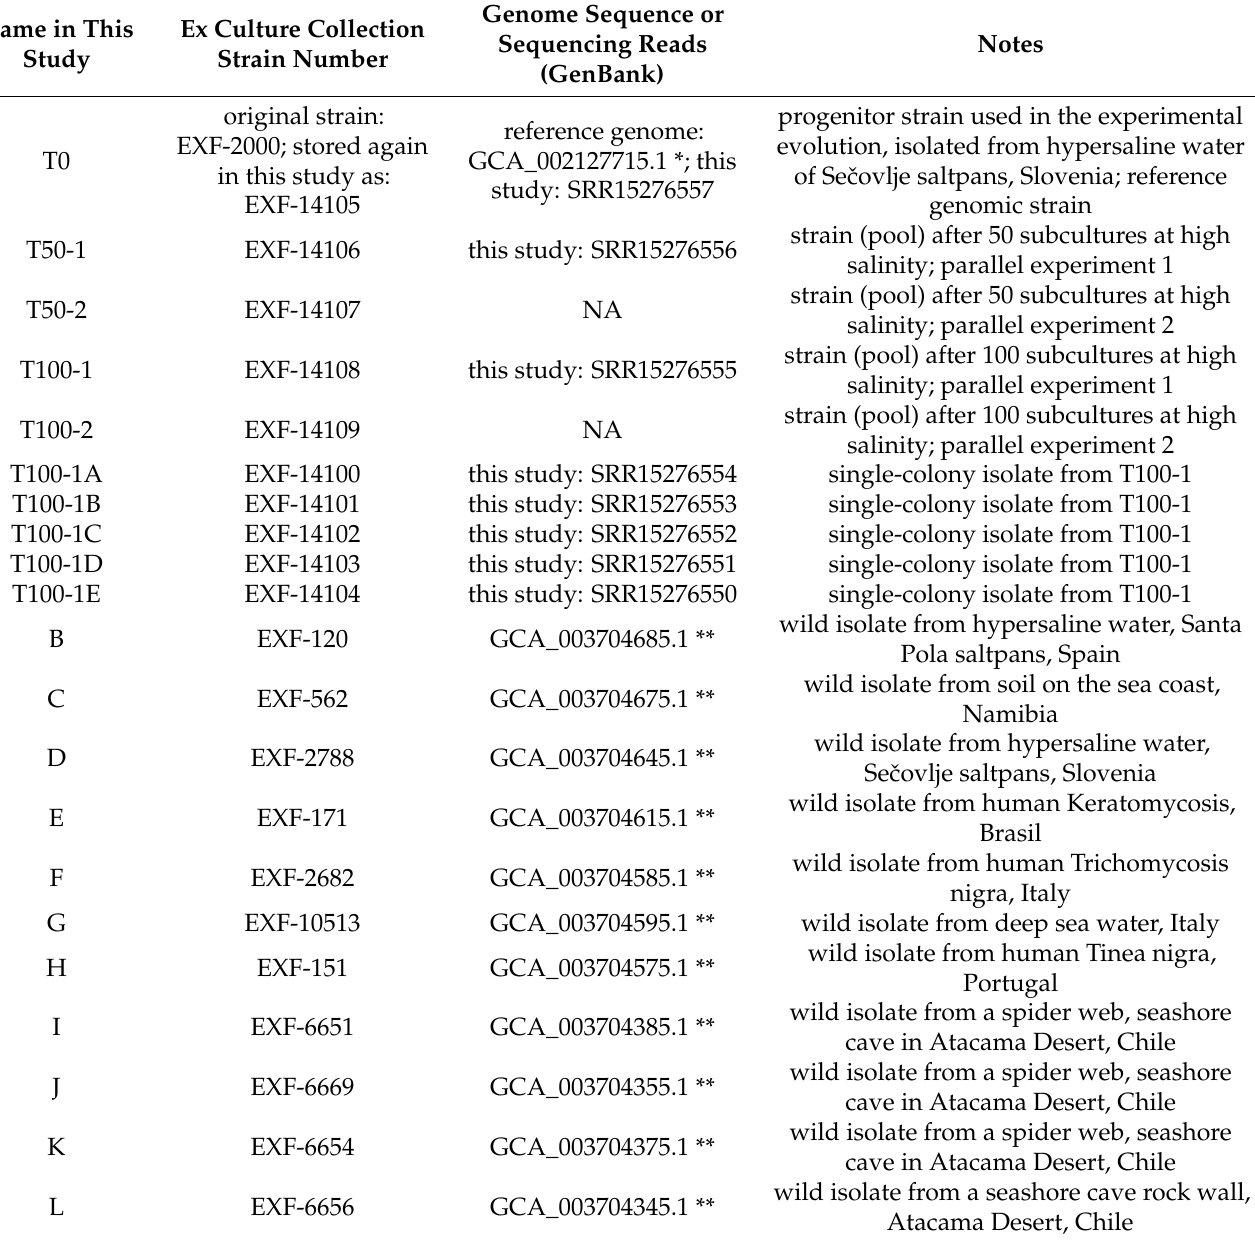
Table 1. Strains of Hortaea werneckii compared in this